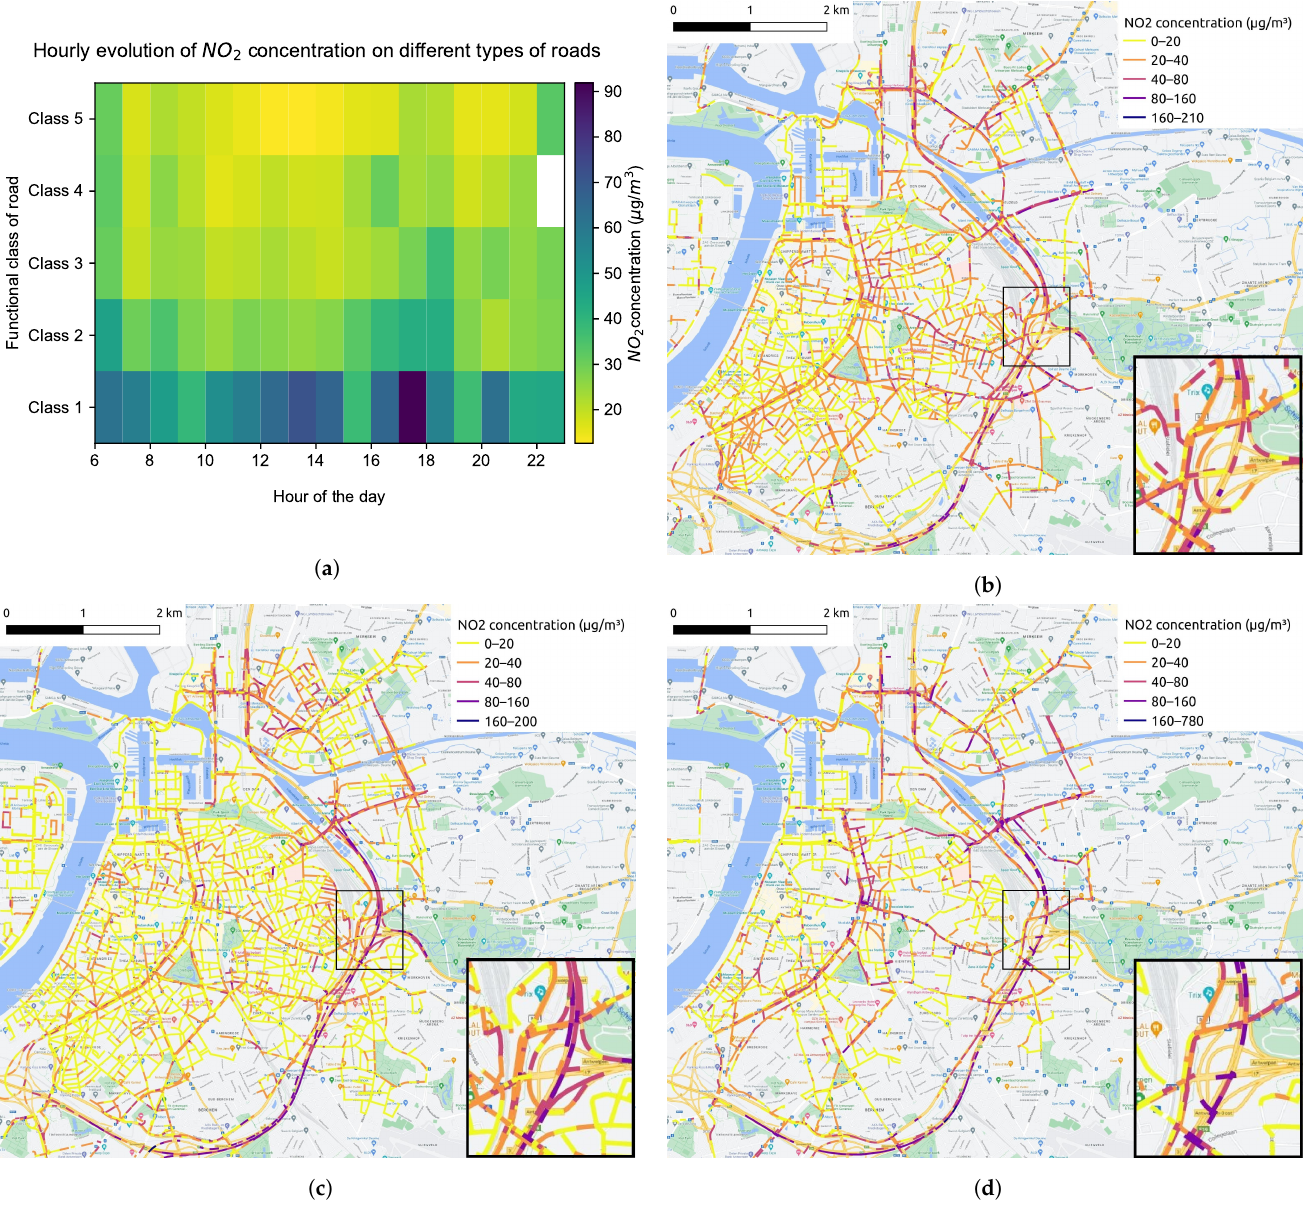
Figure 6. ( a ) The hourly evolution of NO 2 concentration on different types of roads. The map of average NO 2 concentration at 100 m road segments during ( b ) morning rush hours (6:00 ∼ 10:00), ( c ) midday hours (11:00 ∼ 15:00) and ( d ) evening rush hours (16:00 ∼ 20:00),